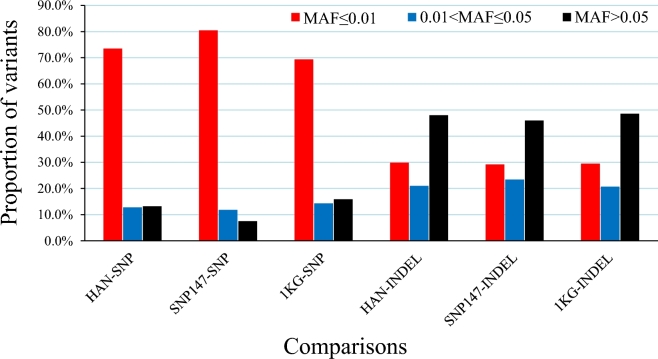
The proportion distribution of novel SNPs and InDels against minor allele frequency. HAN-SNP: the comparison of the SNP set generated from our 90 Han Chinese and the SNP set from the Han Chinese of the 1000GP. SNP147-SNP: the comparison of SNPs between our 90 Han Chinese and the dbSNP build147. 1KG-SNP: the comparison of the SNP sets between 90 Han Chinese and 1KG phase III release. HAN-INDEL: the comparison of INDELs between 90 Han Chinese and Han Chinese from 1000GP. SNP147-INDEL: the comparison of INDELs between 90 Han Chinese and dbSNP build147. 1KG-INDEL: the comparison of INDELs between 90 Han Chinese and 1000GP phase III release.